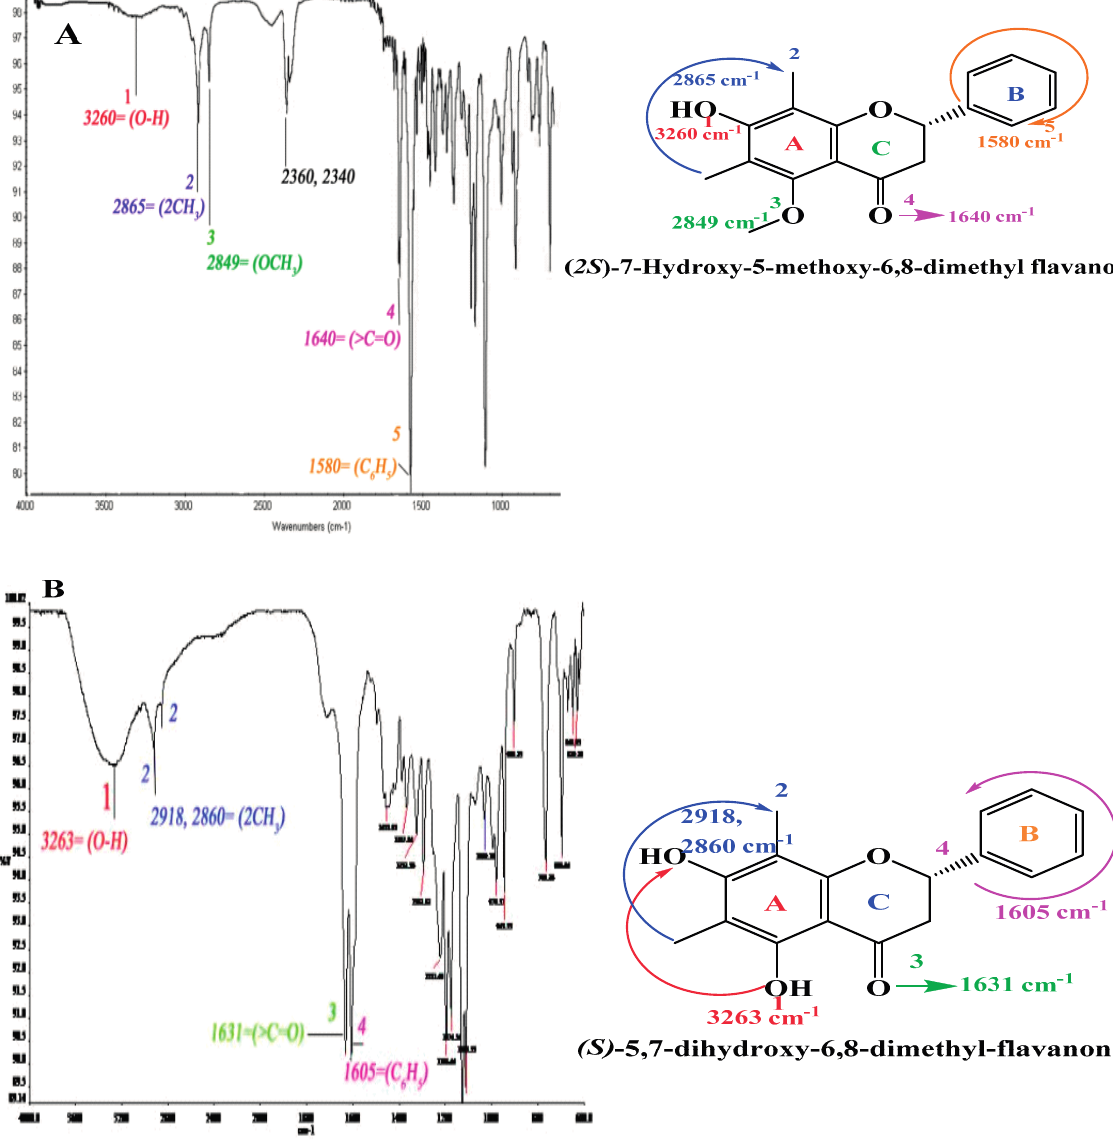
Figure 2. FTIR-spectra of compounds: (2 S )-7-Hydroxy-5-methoxy-6,8-dimethyl flavanone ( A ) and ( S )-5,7-dihydroxy-6,8-dimethyl flavanone ( B ). Principle component analysis (PCA) of five different age plants ( A – C ) has shown that all extracts have different region of absorption because of the different concentration of compounds ( 1 – 5 ) Figure 3. PCA data can be used to differentiate age of plant with maximum concentration of all compounds ( 1 – 5 ). LC-EIMS analysis of compound ( 1 and 2 ) indicated molecular formulae C 18 H 18 O 4 ( m / z 298.10 calc. [M] + 299.10), and C 17 H 16 O 4 ( m / z 284.10 calc. [M] + 285.10), respectively. The molecular weights of compounds ( 1 and 2 ) were determined by liquid chromatography-mass spectroscopy (LC-MS). Compound ( 2 ) showed proposed retrocyclization cleavage of molecule [25]. The fragmented molecular ion peaks were observed at 195 and 181 as daughter ions and the main fragmentation peaks at 299 and 285 for compounds ( 1 and 2 ), respectively (Figure